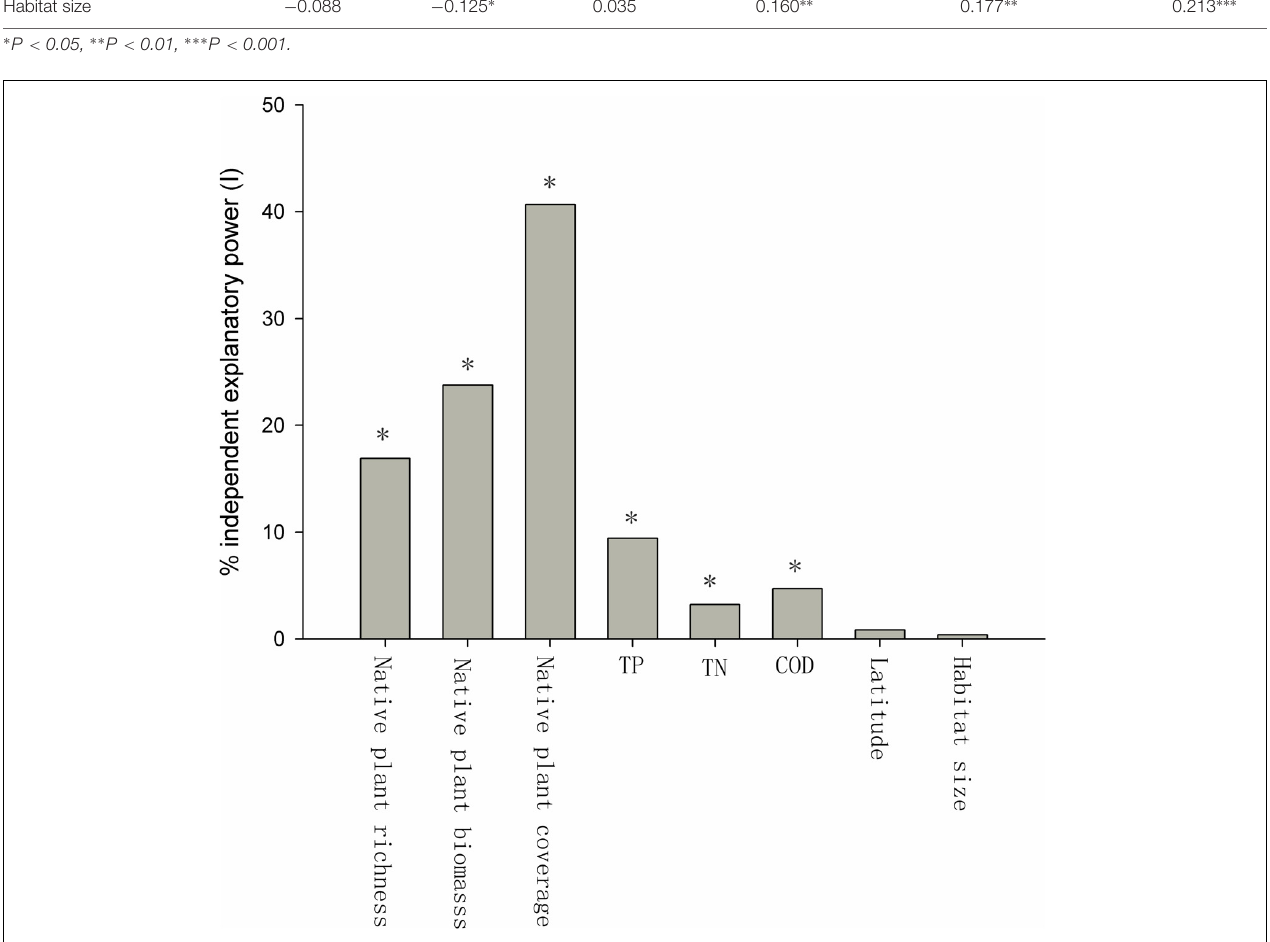
FIGURE 3 | Percent independent explanatory power ( I ) of biotic and abiotic factors of exotic plant richness. The Z -scores were 14.21 (native plant richness), 15.42 (native plant biomass), 31.91 (native plant coverage), 3.61 (TP), 1.72 (TN), 1.92 (COD), 0.35 (latitude), and 0.14 (habitat size). ∗ The Z -score is considered significant at P ≤ 0.05 ( Z ≥